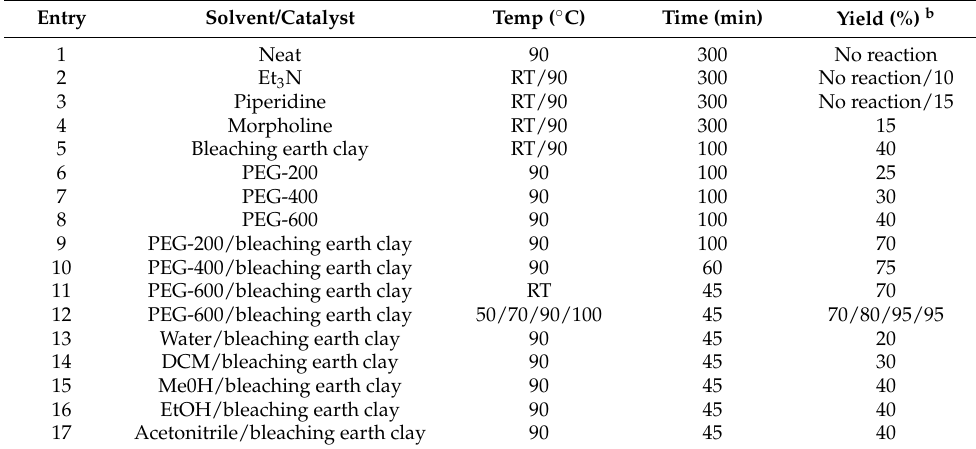
Table 1. Optimization of reaction conditions a